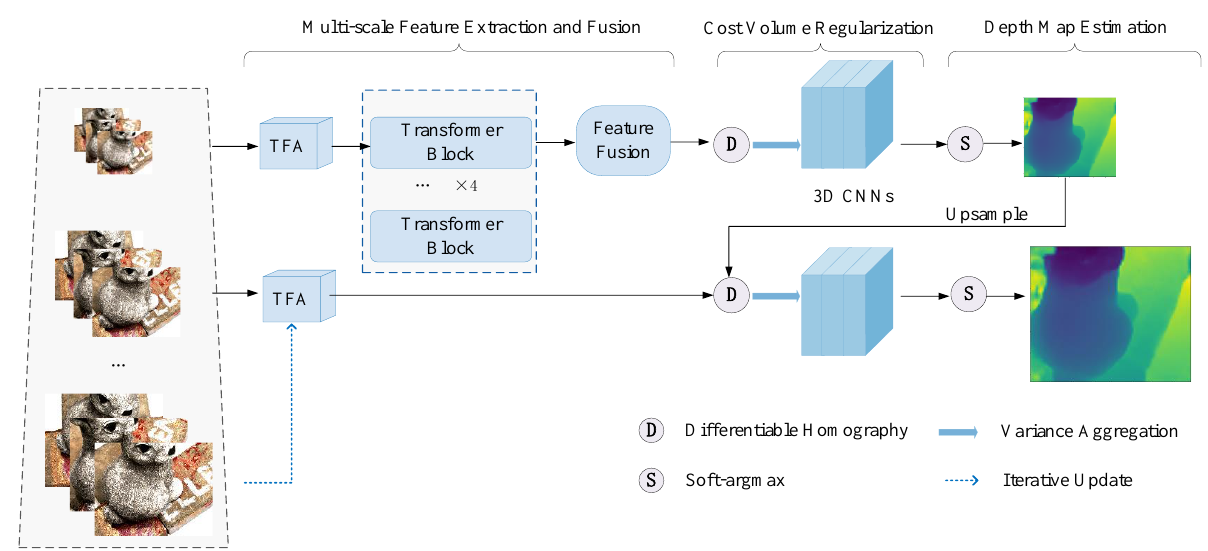
Figure 1. The network structure of MVS-T.